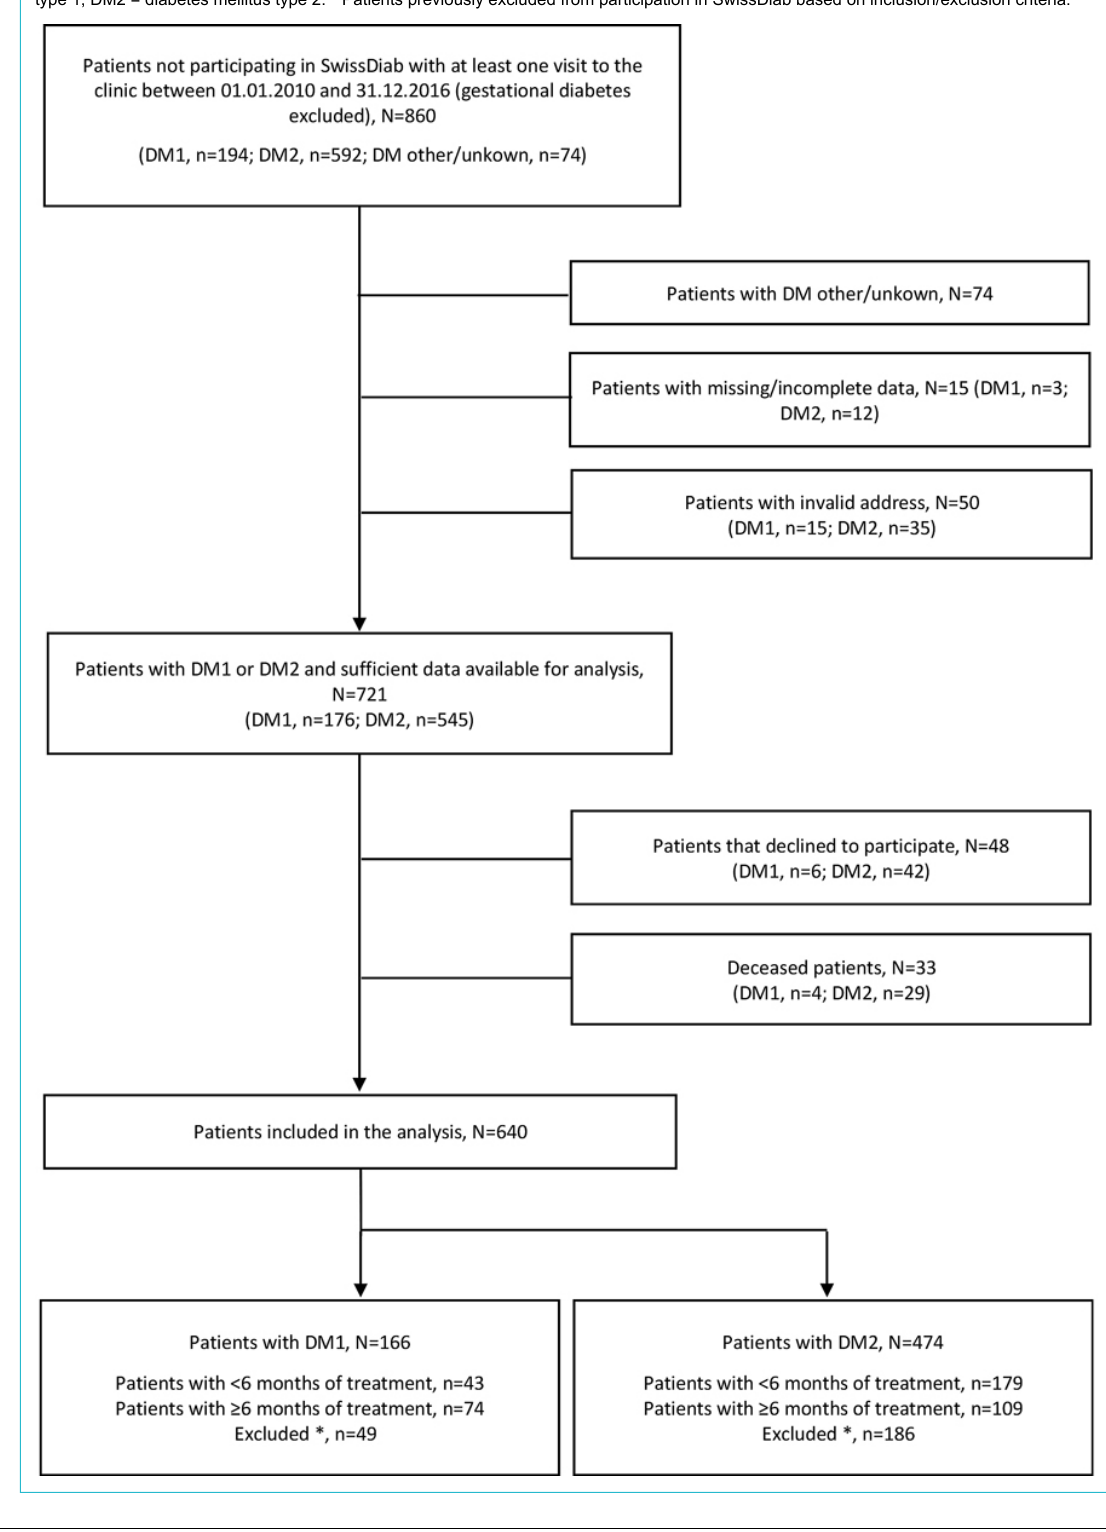
Figure 1: Flowchart showing the exclusions applied when identifying patients with DM1 or DM2 who were not participating in SwissDiab and were eligible for the current analysis. See “Nonparticipating patients” for more details on the exclusion criteria applied. DM1 = diabetes mellitus type 1; DM2 = diabetes mellitus type 2. * Patients previously excluded from participation in SwissDiab based on inclusion/exclusion